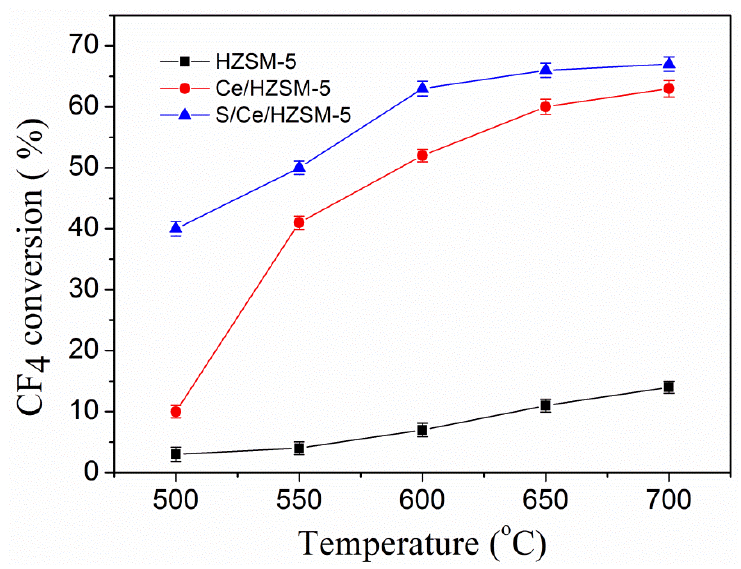
Figure 5. CF 4 conversion reaction over catalysts at different temperatures.